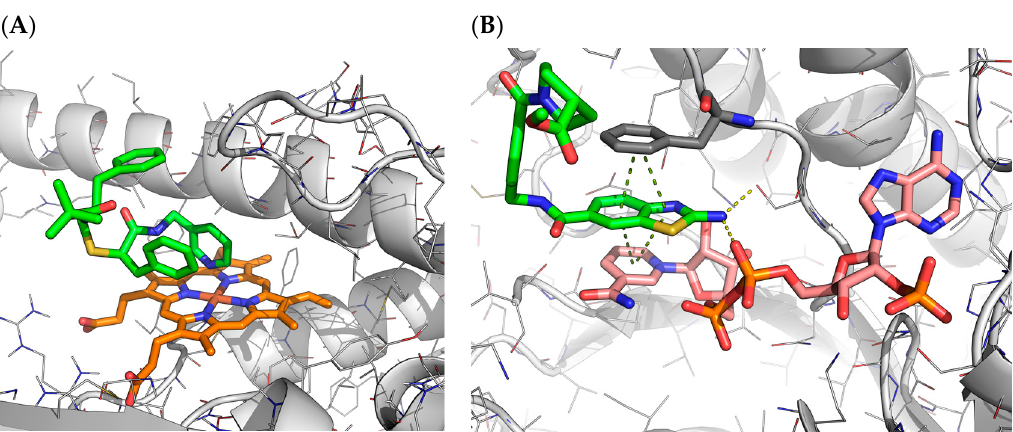
Figure 11. ( A ) Interaction of ligand G0D (green) with heme group (orange) in PDB 6DA2 [33].Ligand belongs to a series of analogues with pyridine as a heme-ligating head that works as an inhibitor of CYP3A4 by decreasing the heme reduction rates [33]. ( B ) Interaction of ligand EV8 (green) and NADP (pink) in PDB 6gd0. In yellow dashed lines are H-bond interactions and in green dashed lines π interactions.